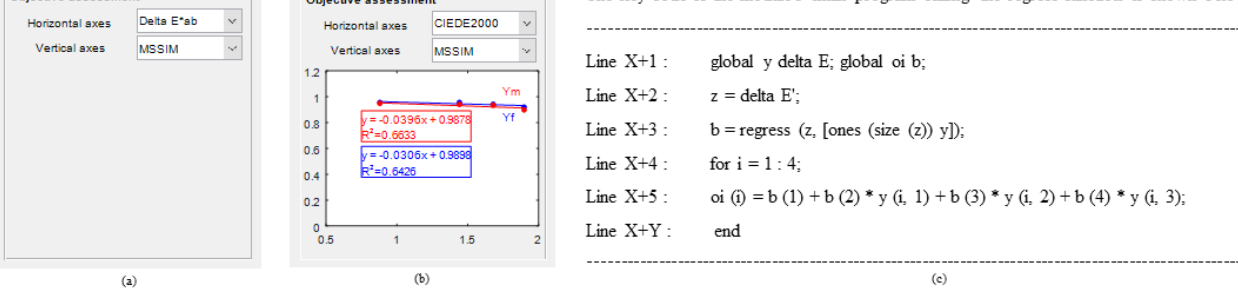
Figure 17. Interface design and demonstration of the calling codes in Module 7: ( a ) initialization; ( b ) terminal; ( c ) code show. Table 7. Types, labels, and roles of controls used in the Module 7 interface. Type of Controls Tag of Controls Role of Controls